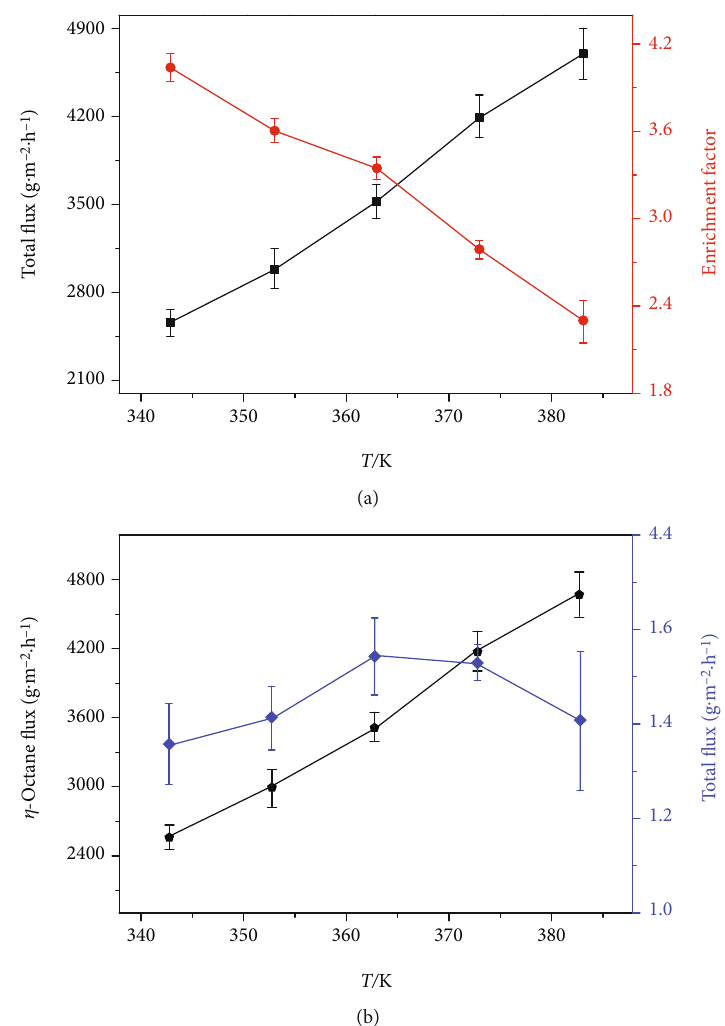
Figure 12: E ff ect of feed temperature on (a) total fl ux and enrichment factor, (b) thiophene fl ux, and n -octane fl ux of PEG/MYNS